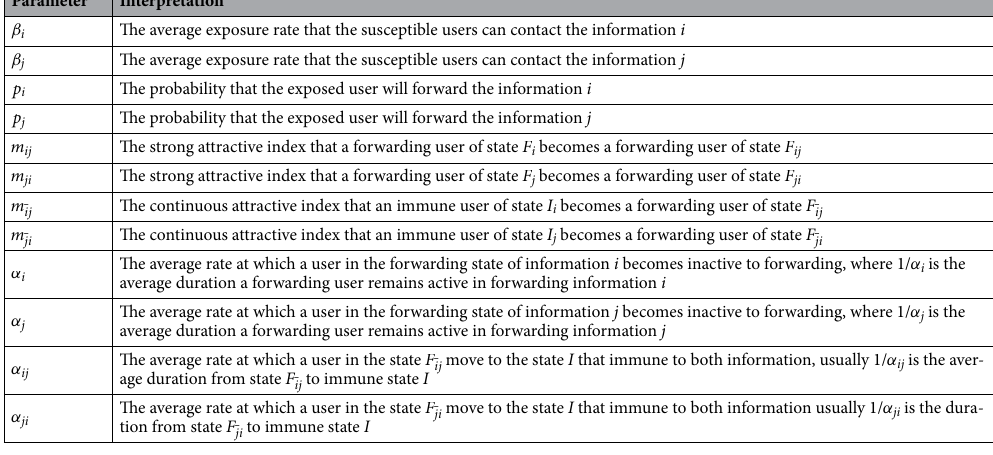
Table 1. Parameters definition.